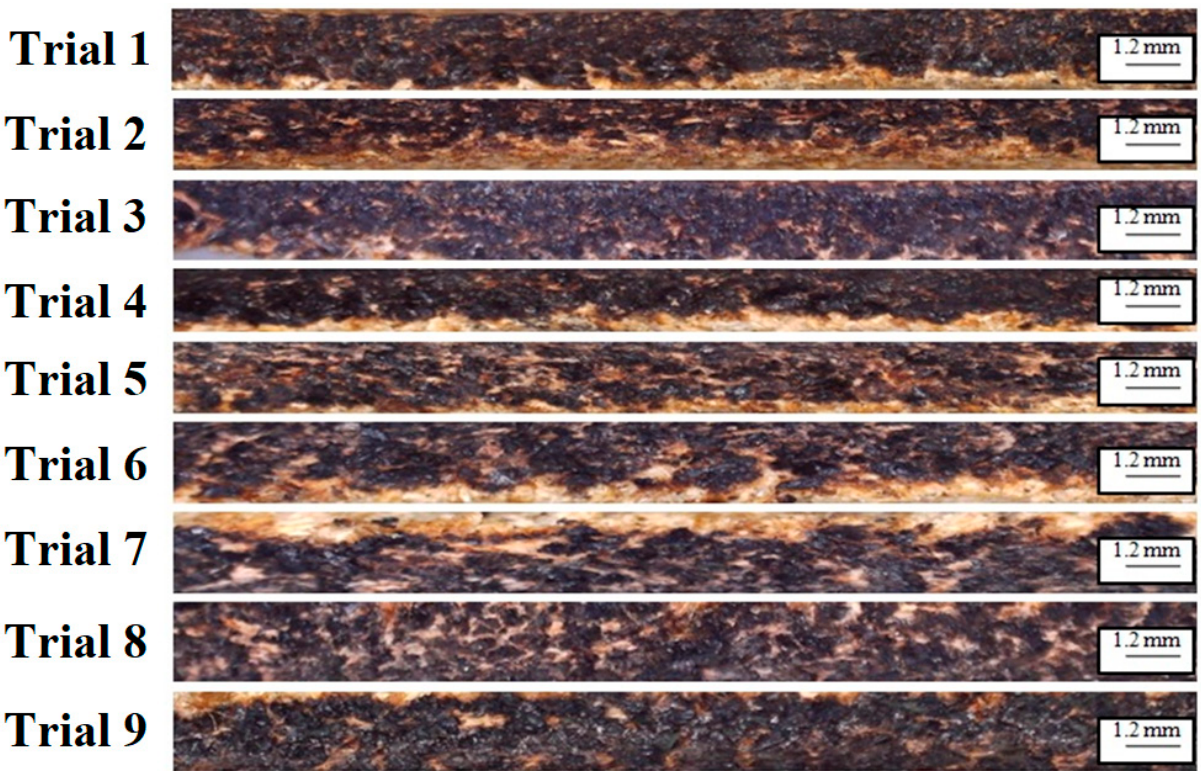
Figure 6. Leather cross-section captured using digital microscope.